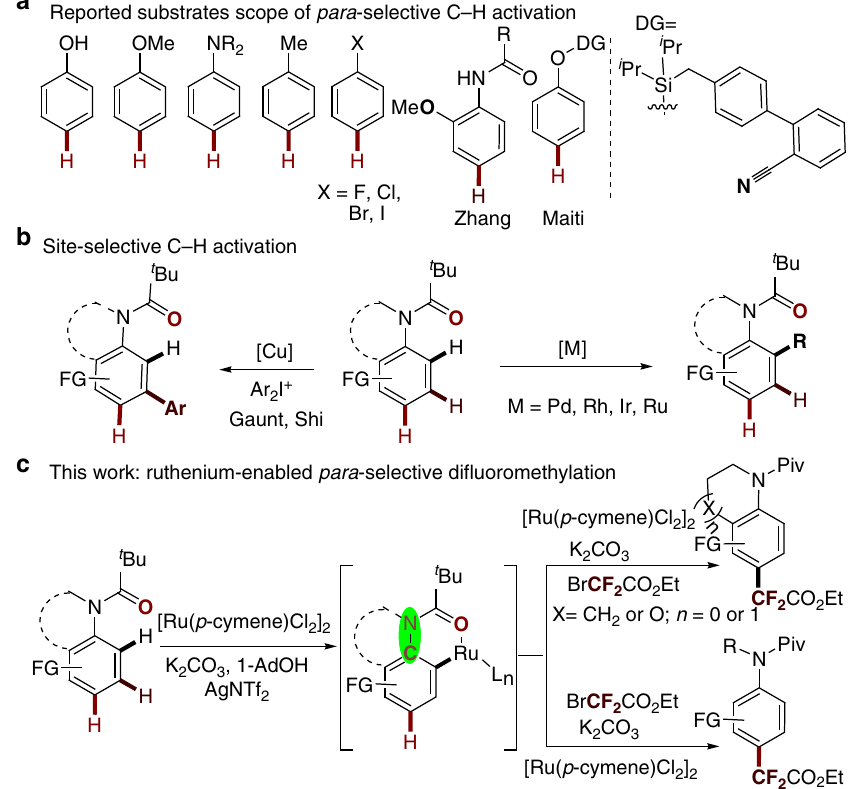
Fig. 1 Site-selective C – H activation reactions. a Reported substrate scope of para -selective C – H activation. b Site-selective C – H activation. c Our work on ruthenium-enabled para -selective di fl